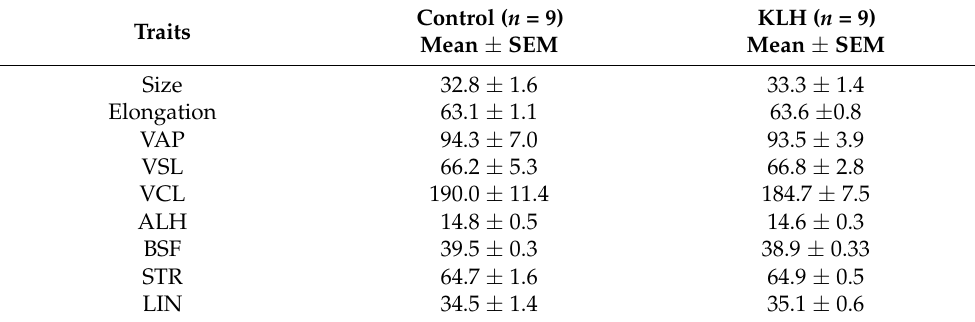
Table 1. Spermatozoa characteristics of the control and immunized (KLH) CD1 male mice. Traits